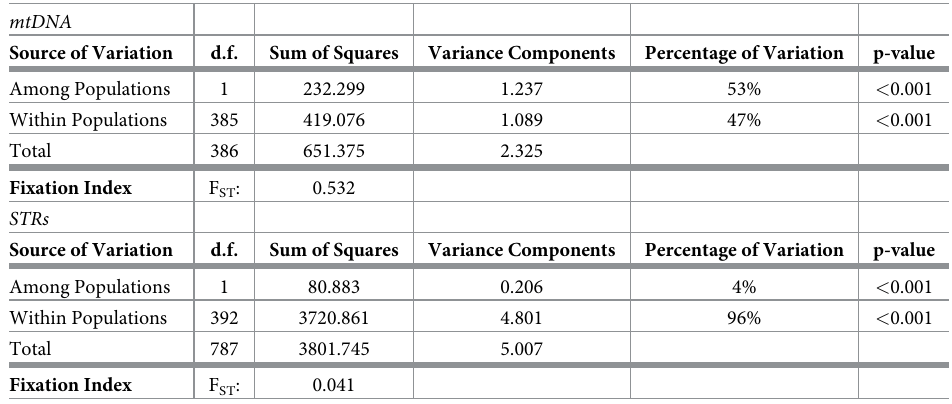
Table 3. AMOVA results with FST. Percent variation is given among populations (Va) and within groups (Vb). The significance of differentiation within and among populations was tested by 1,000 permutations.